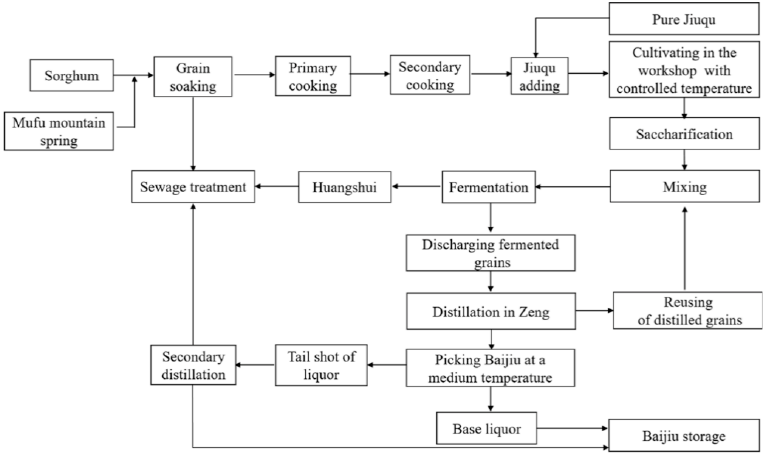
Figure 9. Automatic brewing process of solid-state fermentation for Xiaoqu light flavor Baijiu (kindly provided by Fenglin distillery of Jingpai Co., Ltd., Huangshi, China).